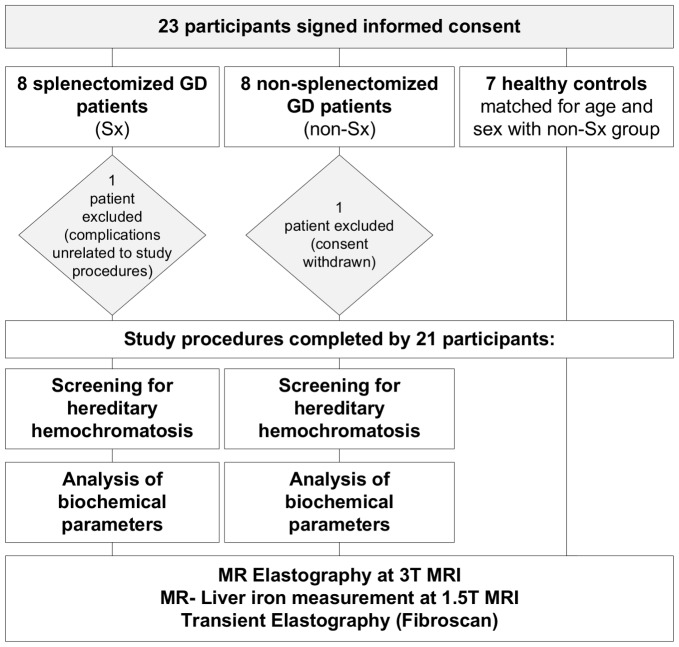
Study flow chart.